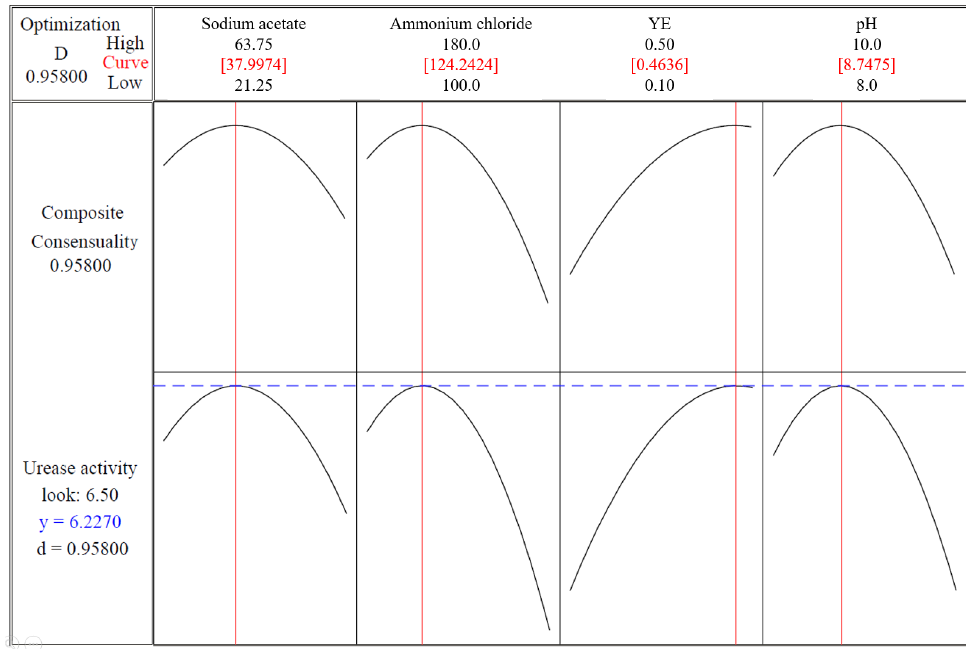
Figure 7. CCD test optimization curve.